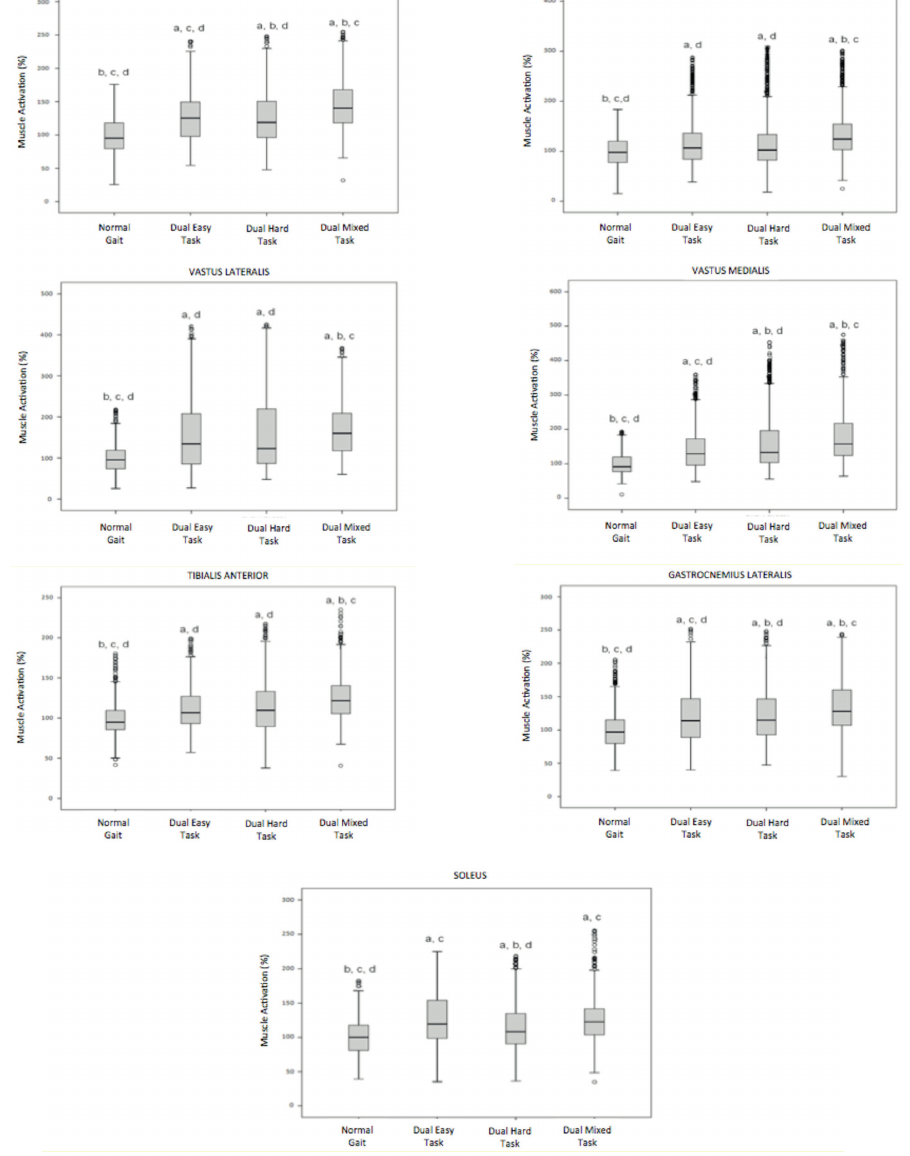
Figure 1 - Medians and quartiles of muscle activation of rectus femoris, biceps femoris, vastus lateralis, vastus medialis, medial, tibialis anterior, gastrocnemius lateralis and soleus for normal gait, gait with dual easy task, dual hard task and dual mixed task